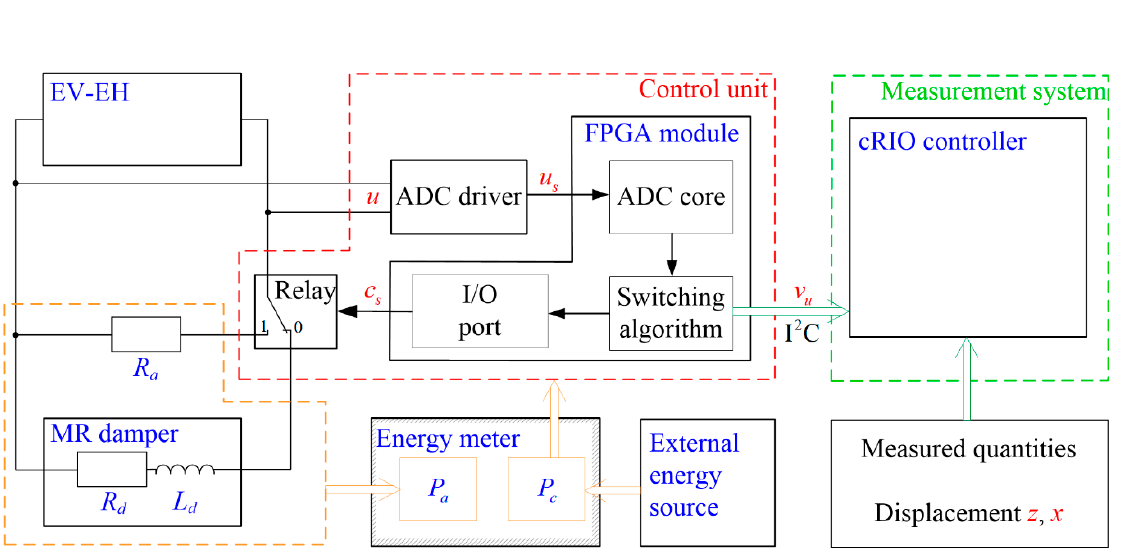
Figure 17. Self-sensing and self-powered action for MR damper switching control.